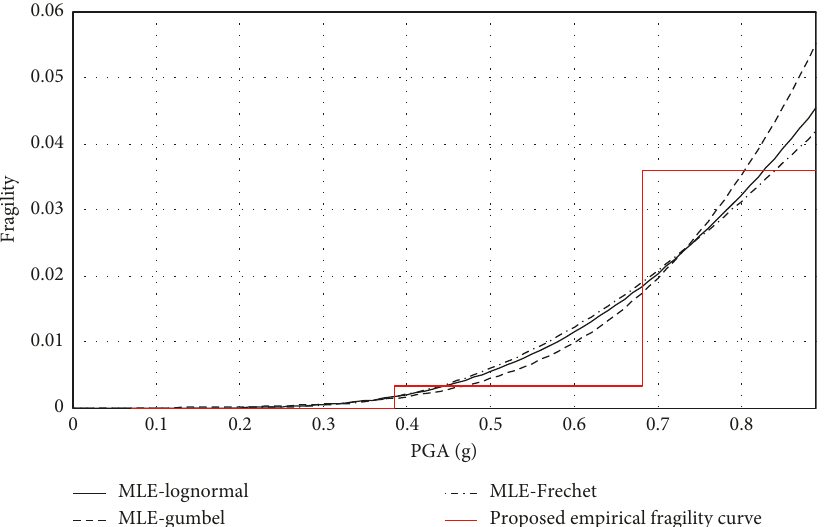
Figure 10: Comparison of empirical fragility curves of damage state with Collapse.